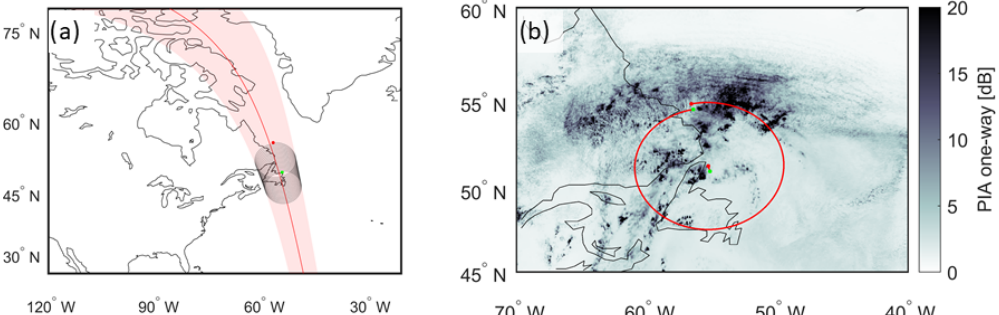
Figure 9. (a) WIVERN satellite track off the Labrador coast with the satellite ground track (red line), the scanning swath (shaded red region), and the radar footprints (black line) for 20 full revolutions of the conically scanning antenna corresponding to a flight time of 100s. (b) Details of a single revolution of the WIVERN antenna with the one-way path integrated attenuation due to the hydrometeors shown in the background. This rotation sample will be examined in detail later (see Figs. 12–15).